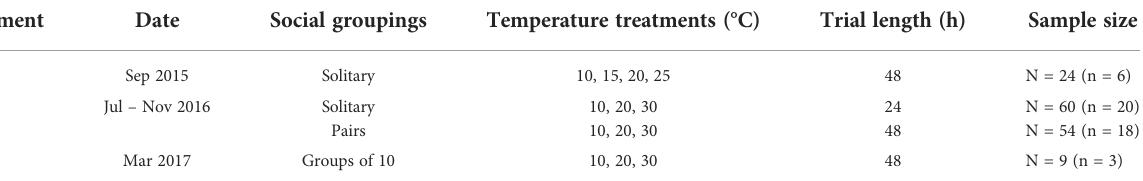
TABLE 1 Summary of laboratory experiments.